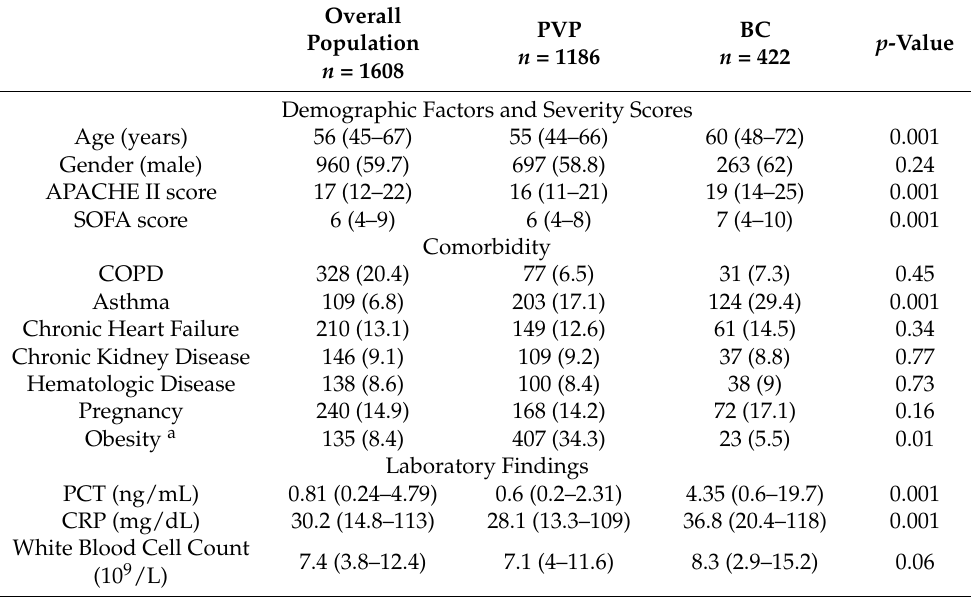
Figure 1. Flow diagram of patient enrollment. Abbreviations: ICU, Intensive Care Unit; PCT, procalcitonin; CRP, C-Reactive protein; PVP, primary viral pneumonia; BC, bacterial co-infection; GPC, Gram Positive bacteria cocci; GNB, Gram Negative bacteria bacilli; PM, polymicrobial. Table 1. Demographic and Clinical Characteristics of the patients enrolled in the Table 1 details the main demographic and clinical characteristics of patients. The me-